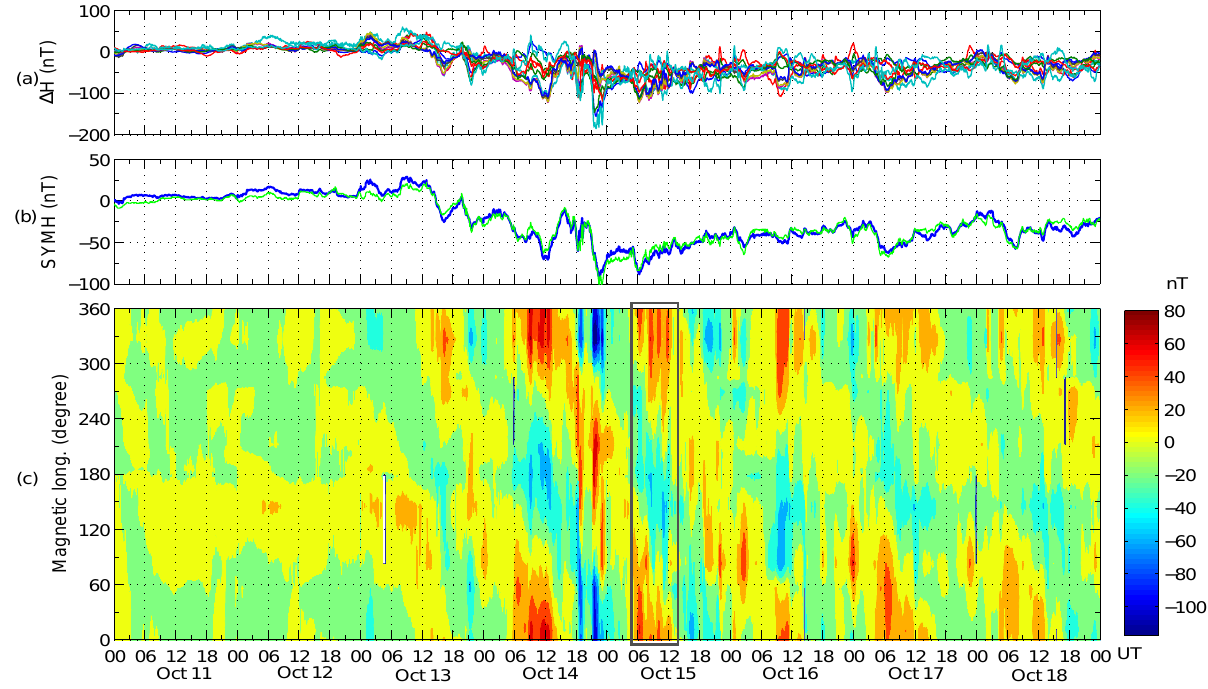
Fig. 1. 1H disturbance, SYMH index and longitude propagation of asymmetric disturbance 1H asym during 11–18 October 2003. (a) Traces of different colours represent 1H observed at longitudinally distributed 11 stations and (b) thick blue line represents zonal mean of 1H , i.e. equivalent SYMH, whereas green line represents SYMH provided by WDC, Kyoto. SYMH calculated using data of 11 stations and 5–6 stations show fairly similar variations. (c) X-axis represents time in UT, Y-axis represents magnetic longitude and the 1H asym observed at stations has been colour-coded. A clear 24h periodicity in the asymmetric disturbance is evident due to changing local time on the Earth. The grey rectangle shows the duration selected for detailed